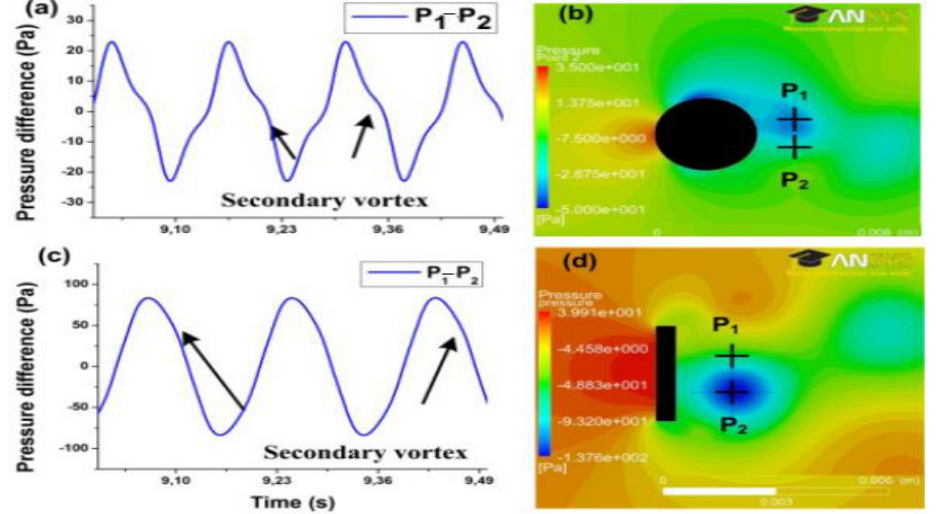
Figure 9. ( a ) Comparison of vortex pressure in the cylindrical bluff body wake; and ( b ) associated pressure difference; ( c ) when a vortex is present in the cubical bluff body wake; and ( d ) associated pressure difference [148]. Table 2. Techniques of PEH in Wind Flow.